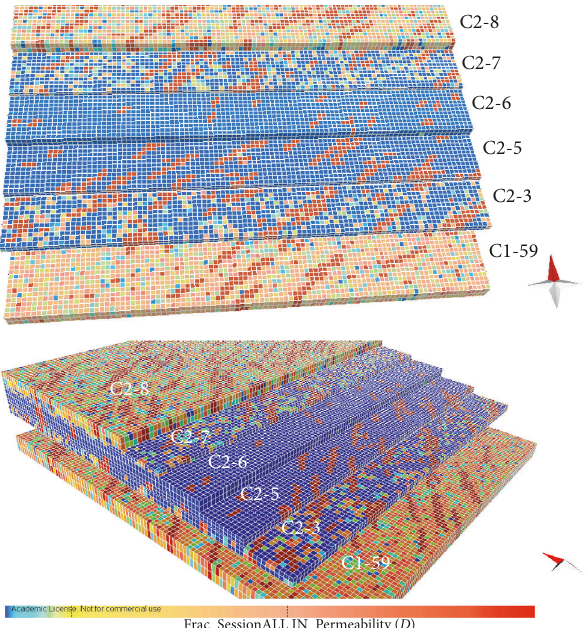
Figure9:Finalmodel(10000 m 2 atthebaseandheightproportional to the measured layer thickness) of relative permeability (𝐷) associated with fractures studied at the two scales of observations.